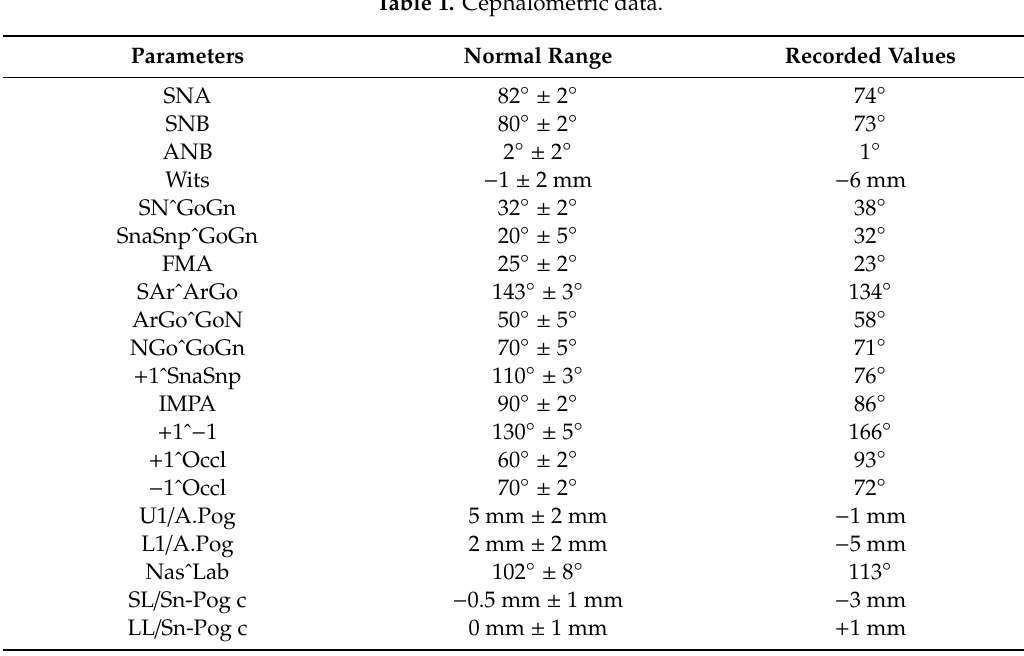
Figure 3. Pretreatment radiographic records: ( a ) orthopantomogram; ( b ) lateral cephalogram. Table 1. Cephalometric